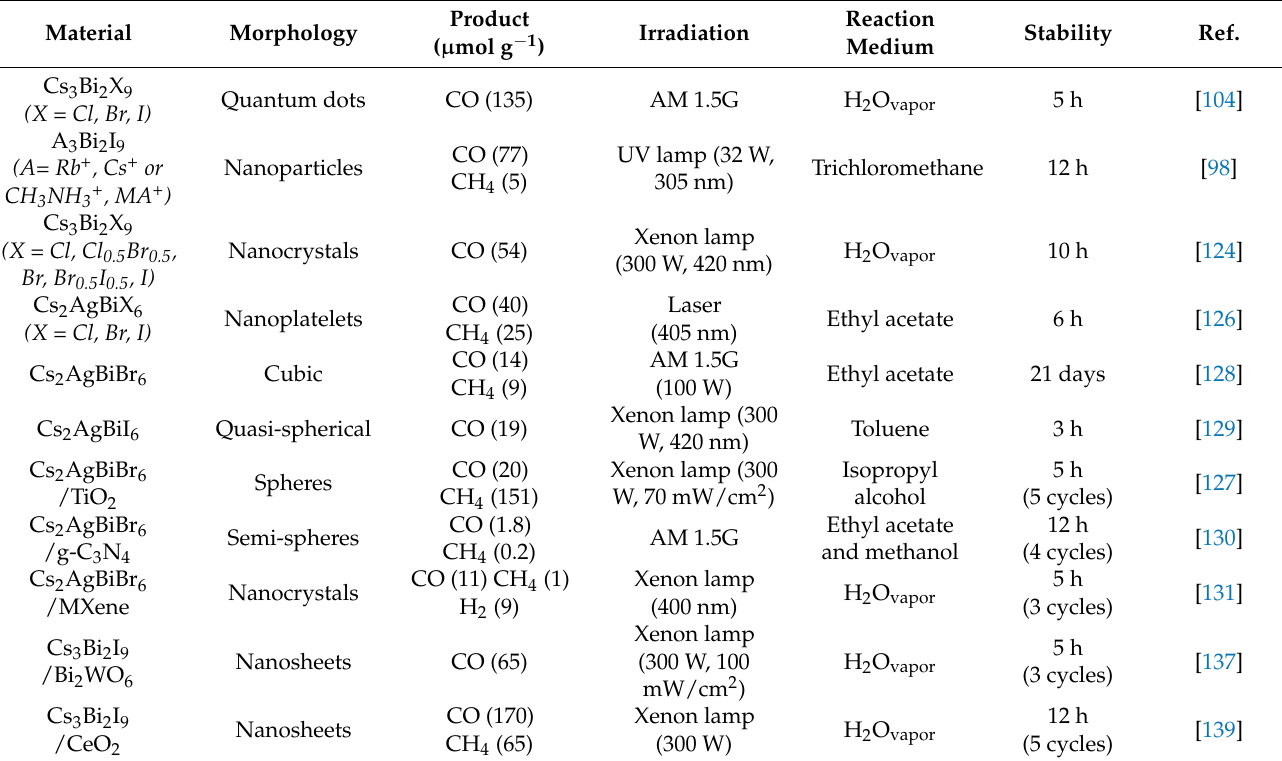
Table 1. Summary of the solar fuels obtained from CO2RR by the implementation of different stability strategies in the Cs 3 Bi 2 X 9 perovskites.